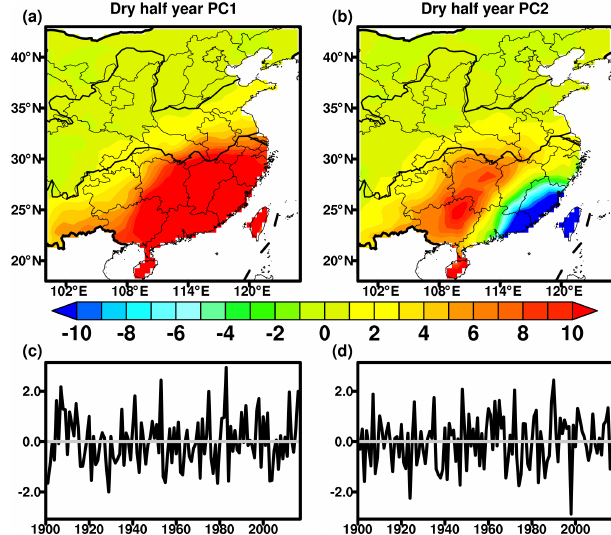
Figure 4. The first (a) and second (b) empirical orthogonal func- tion (EOF) for the rainfall in the dry season. The first (c) and sec- ond (d) principal components (PCs) correspond to these EOFs from the rainfall in the dry season. Both time series are normalized with respect to the corresponding standard